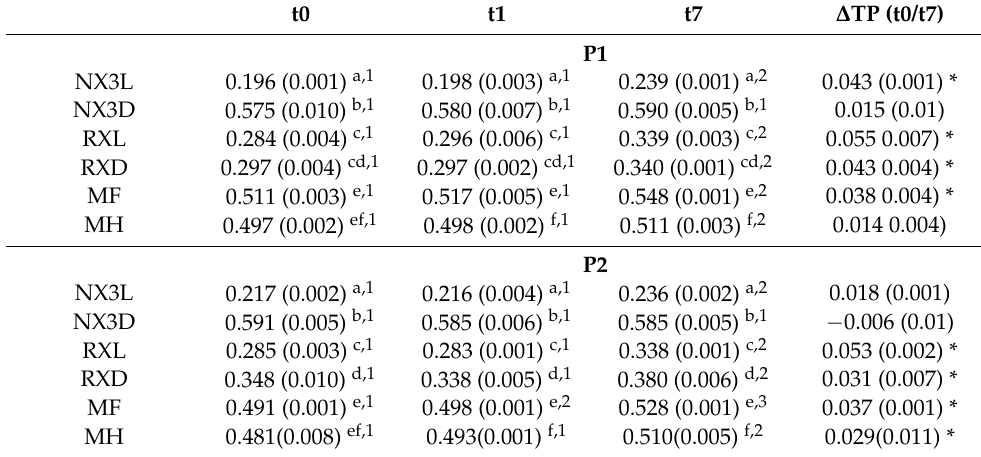
Table 3. Translucency values of the tested resin luting agents cured with the traditional curing protocol (P1) and the step luting protocol (P2) before (t0) and 1 day (t1) and 7 days (t7) of storage in water. ∆ TP (t0/t7) describes the difference between translucency value of t0 and t7. Values are expressed as means (standard deviation). Different superscript letters identify statistical differences between groups at the same time point. Different superscript numbers identify differences between each time point ( p < 0.05), while * identifies a ∆ TP (t0/t7) higher than the perceivable translucency threshold value ± 0.023.